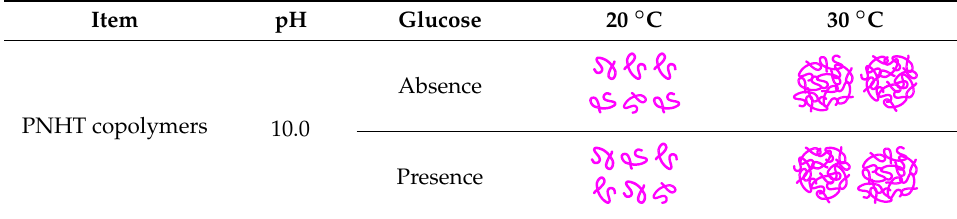
Figure 8. AFM images for glass surfaces with particle deposition of PNHT copolymers in UHQ water at 20 °C ( A ) and 37 °C ( B ).